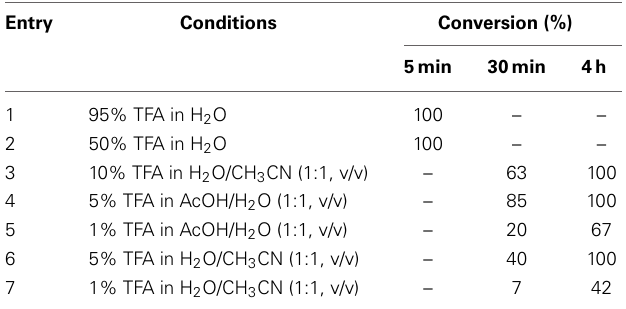
Table 3 | Summary of the LC-MS analysis of the reaction